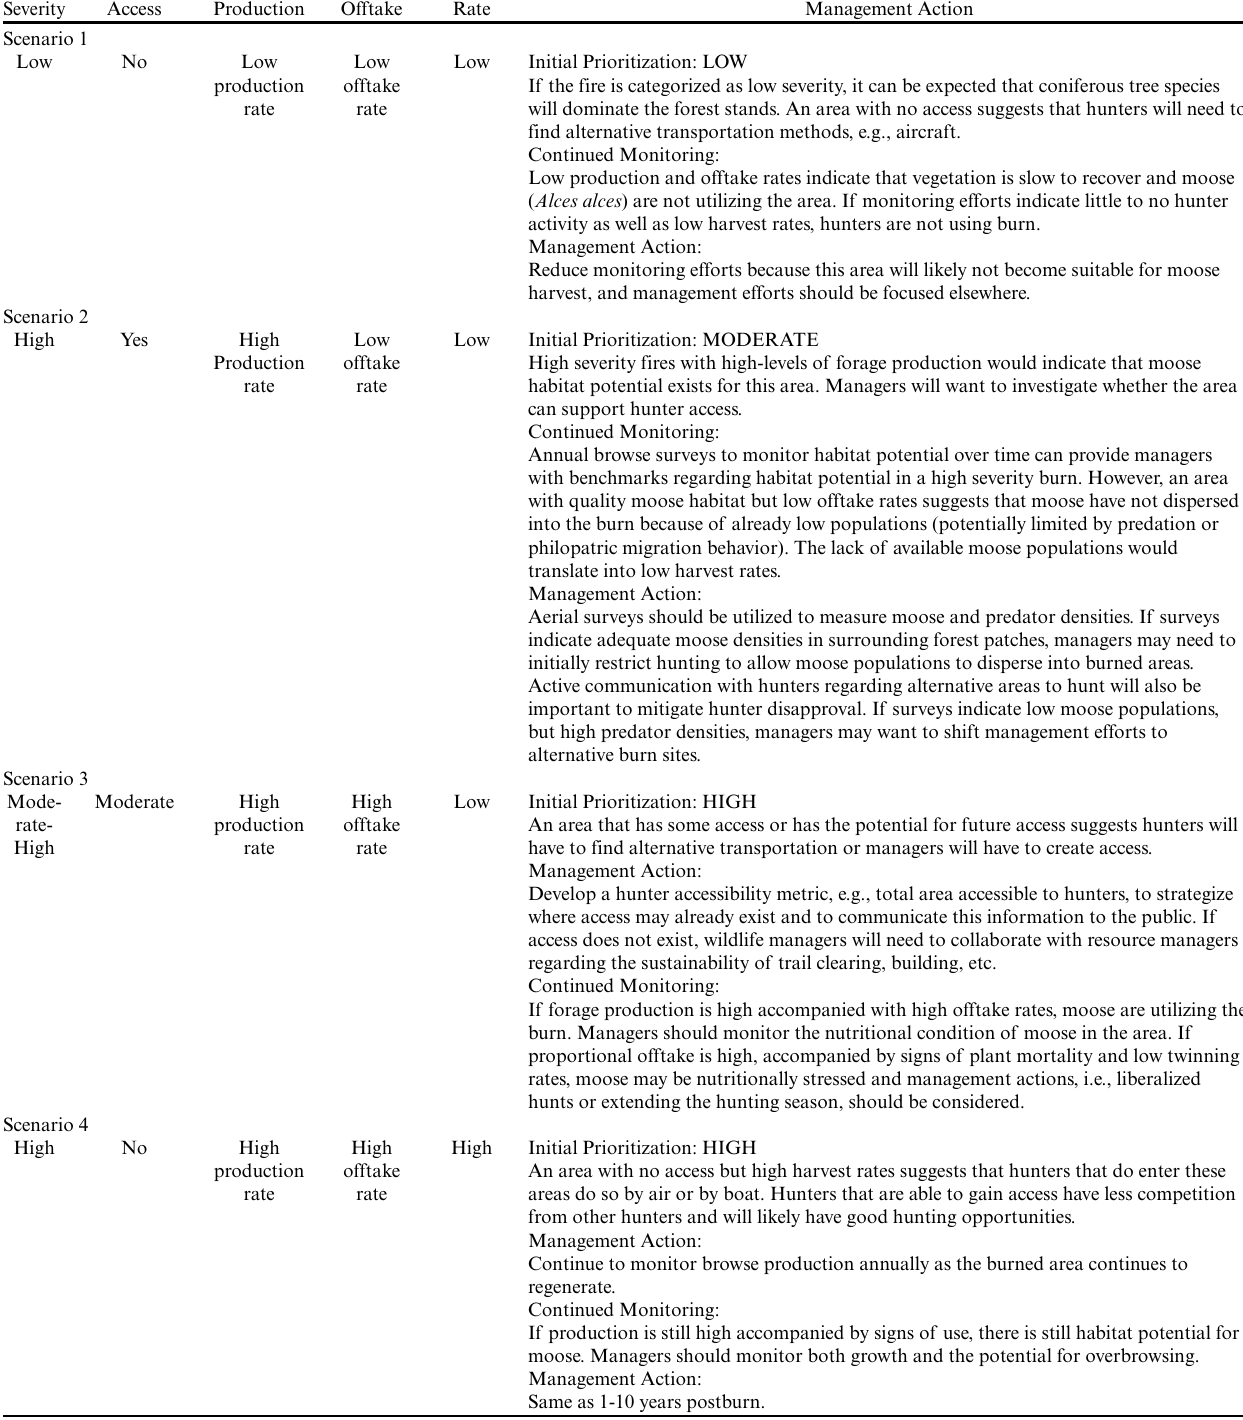
Table 1 . The reported number of moose harvested, number of hunters, and percent success adapted from DuBois (2010) in southwestern game management unit 20D and northeastern game management unit